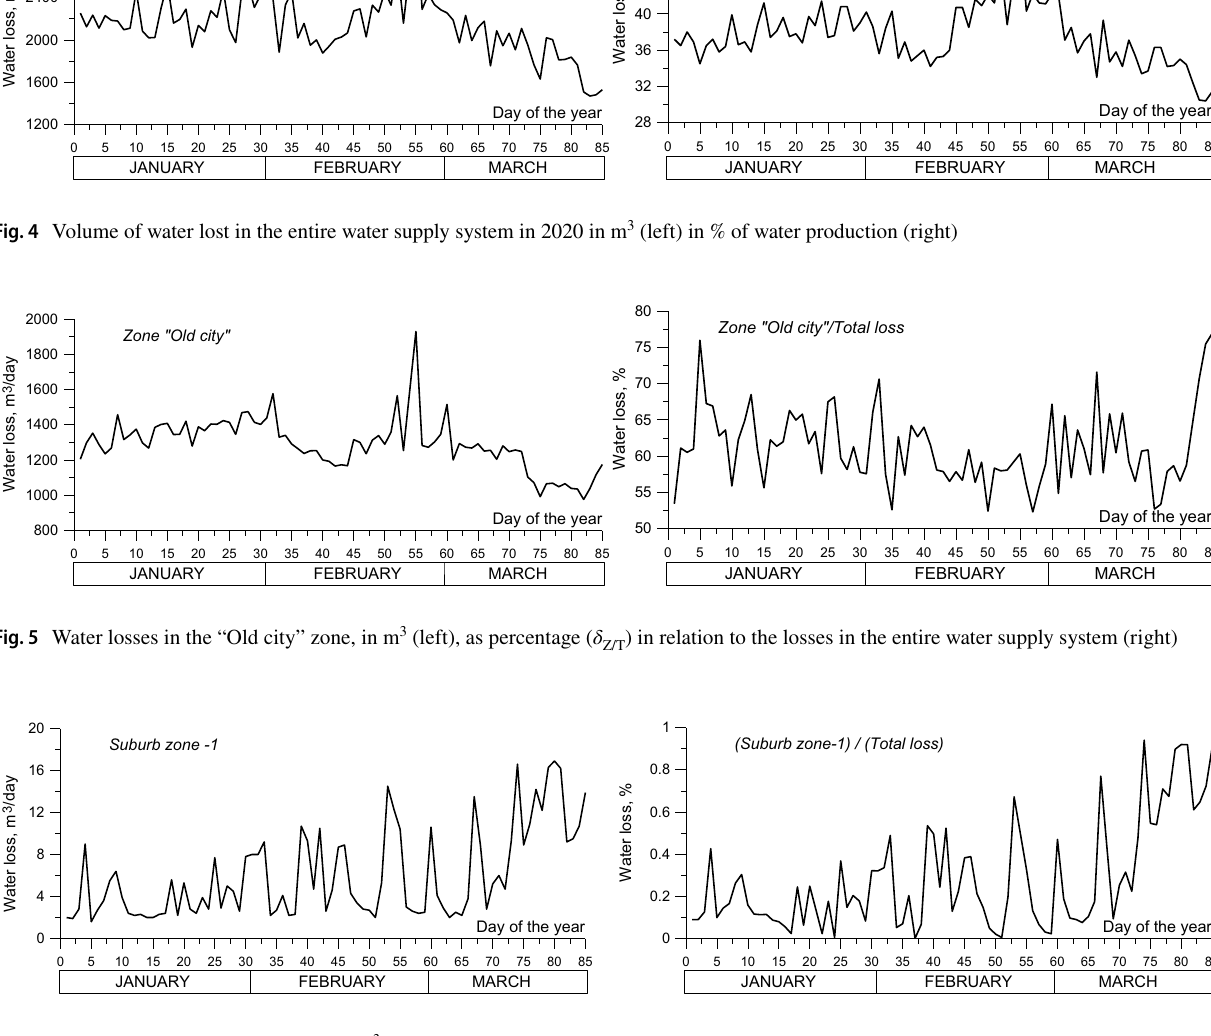
Z/T ) in relation to the losses in the entire water supply system